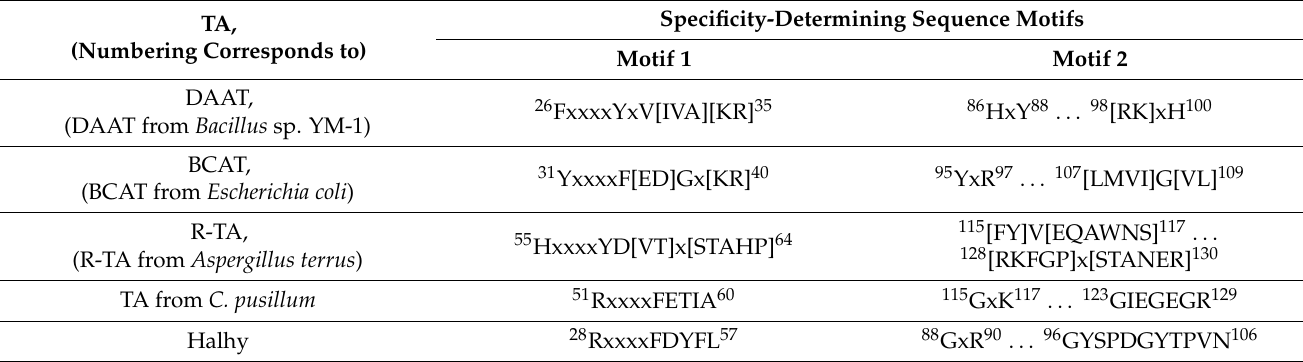
Table 1. The specificity-determining sequence motifs of the canonical DAATs, BCATs, R-TAs, TA with an expanded substrate specificity from C. pusillum and TA from H. hydrossis (Halhy), according to Höhne et al. [6].